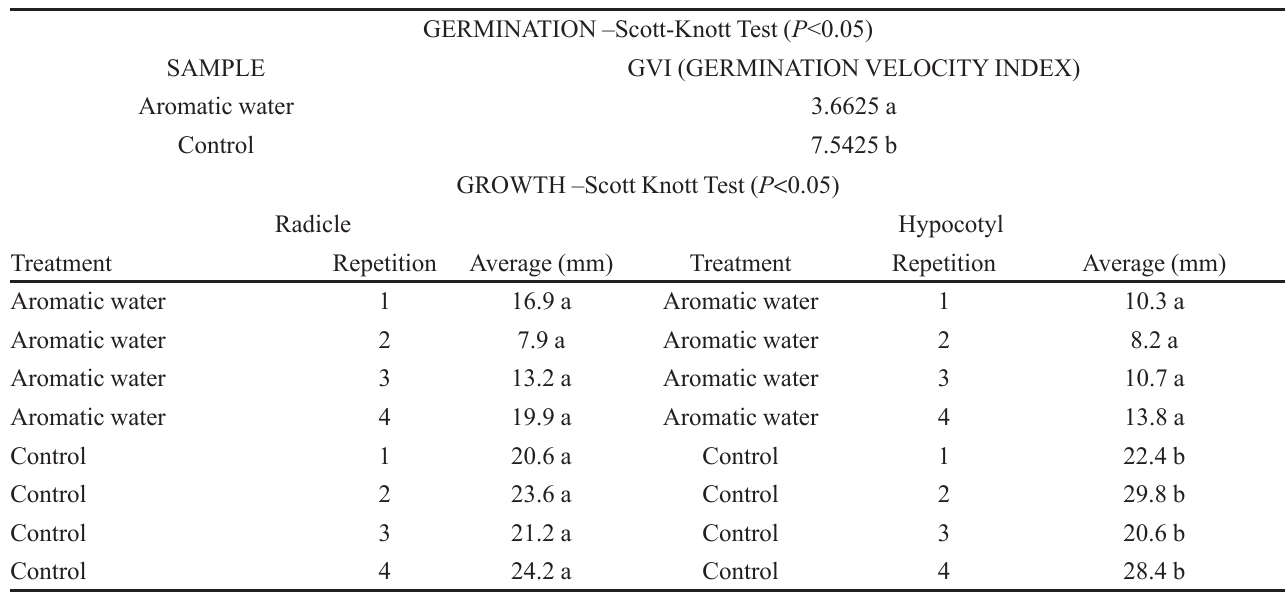
TABLE II - Evaluation of allelopathic activity of aromatic water from A. lanceolatus GERMINATION –Scott-Knott Test ( P